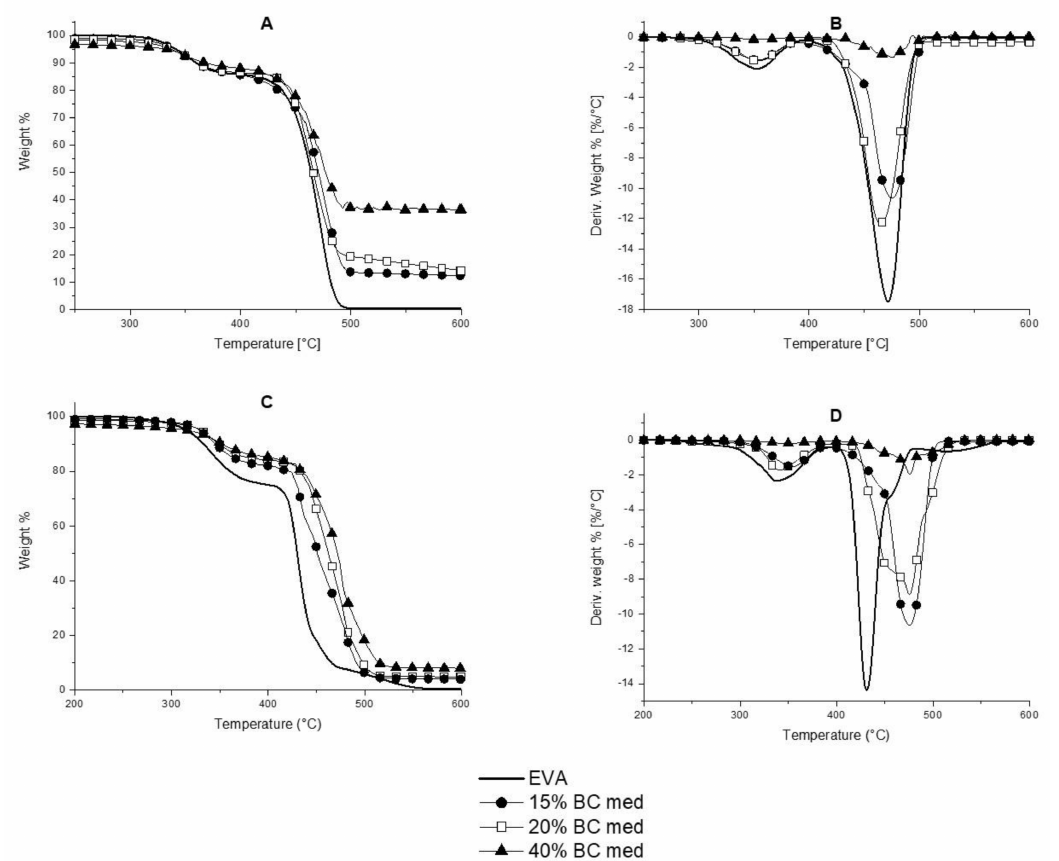
Figure 5. TG and dTG curves of EVA and its compounds containing BC medium in nitrogen ( A , B ) and in air ( C , D